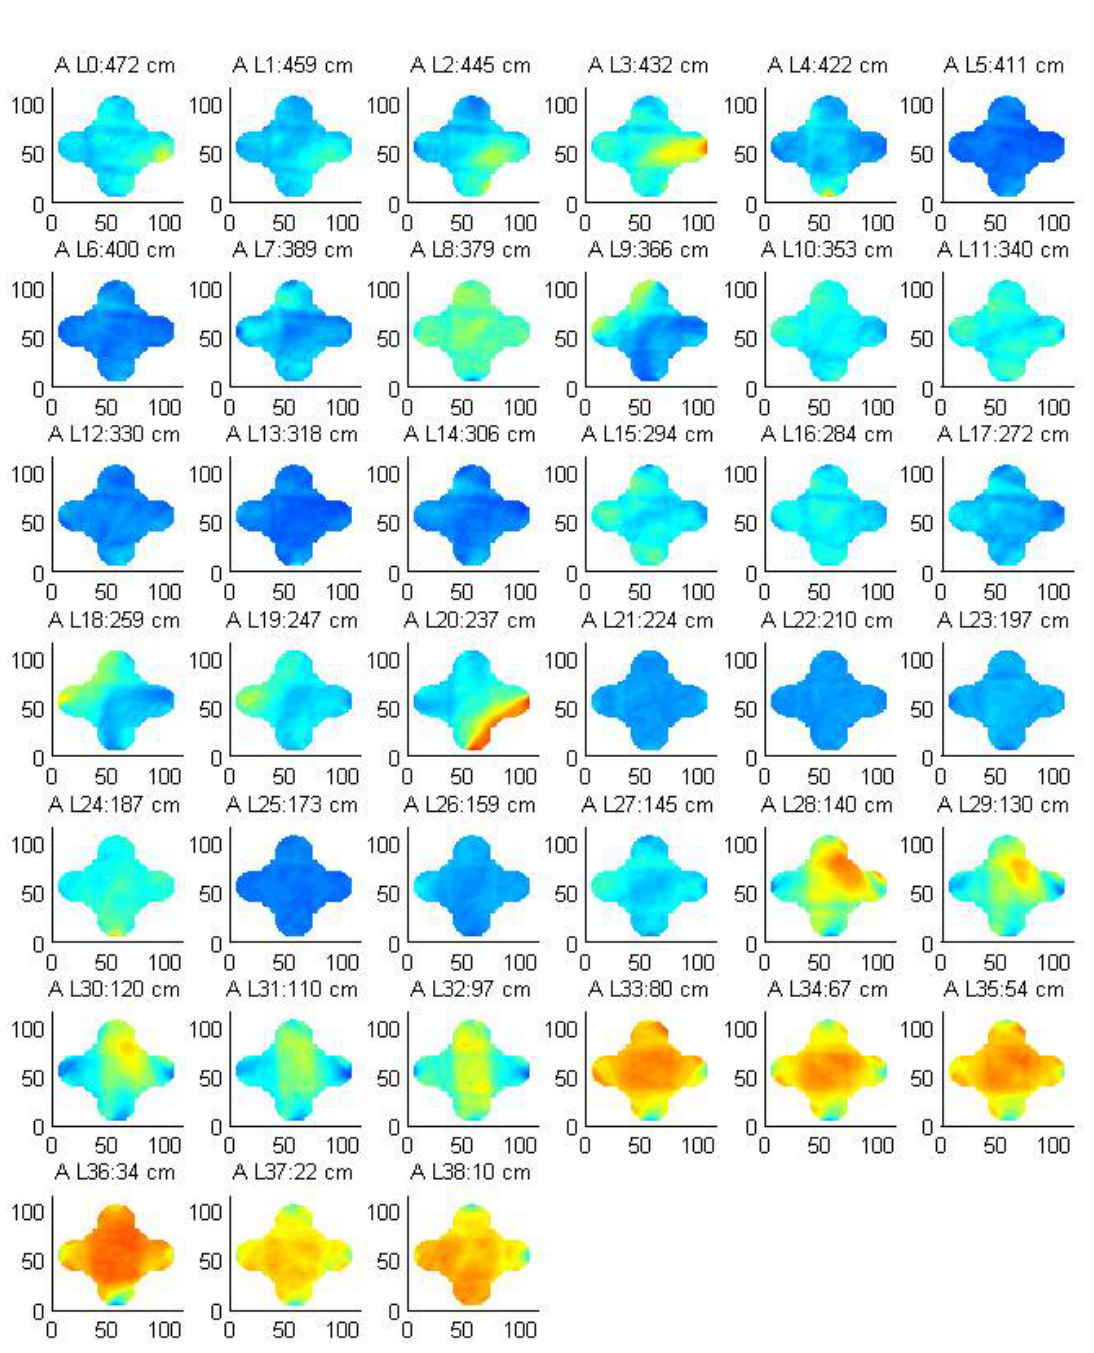
Figure 23. Tomographic images of all drums from column 3.